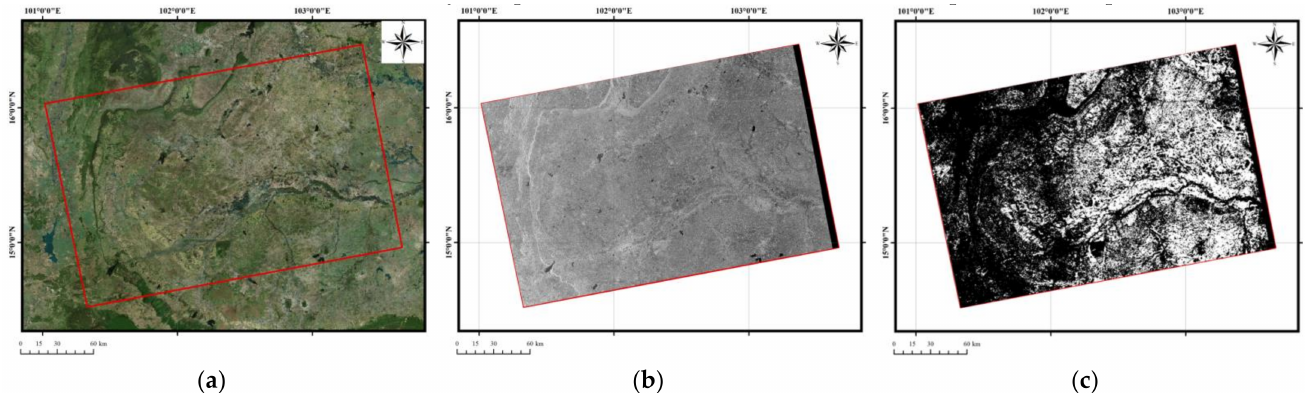
Figure 4. Information of the training image: ( a ) location of frame 99-16; ( b ) the VH polarization of frame 99-16 on 12 January 2018; ( c ) label image of frame 99-16, where bright and dark pixels indicate paddy rice and non-rice,